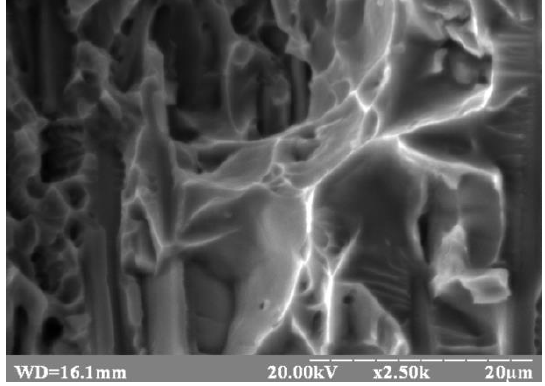
Figure 11. Cellular traces of plastic deformation on fracture surface of a series 7